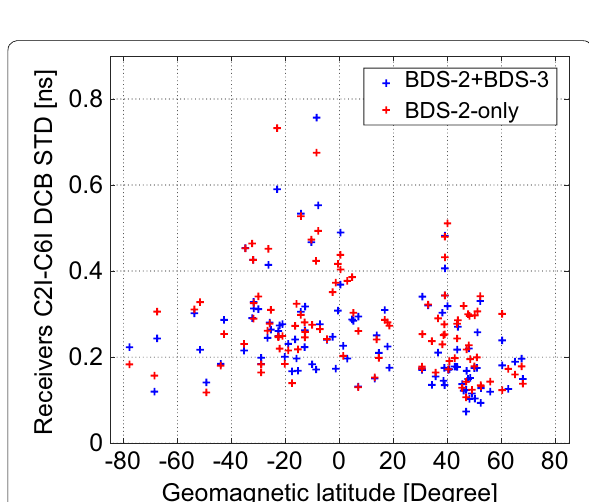
Fig. 9 Distribution of receiver C2I–C6I DCBs STD with geomagnetic